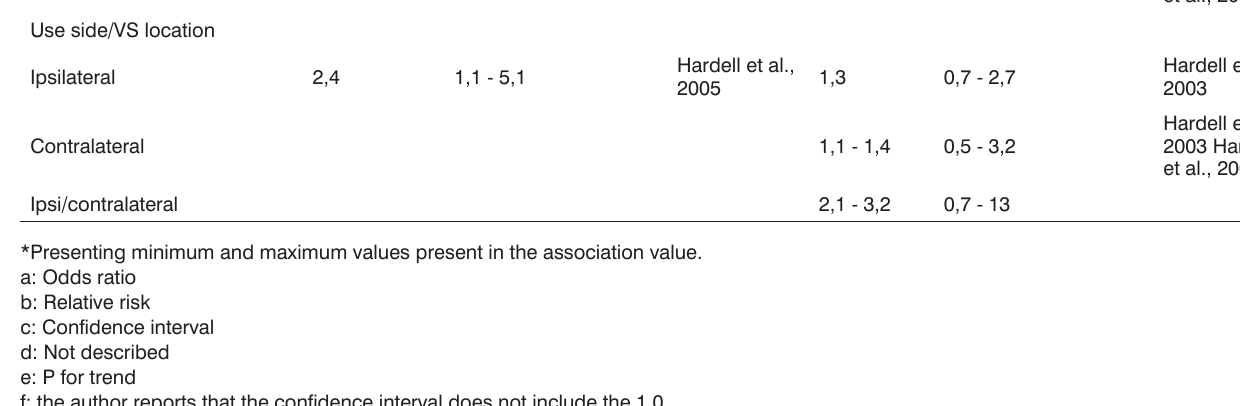
Table 4. Negative associations observed in the studies which analyzed risk factors for the vestibular nerve schwannoma